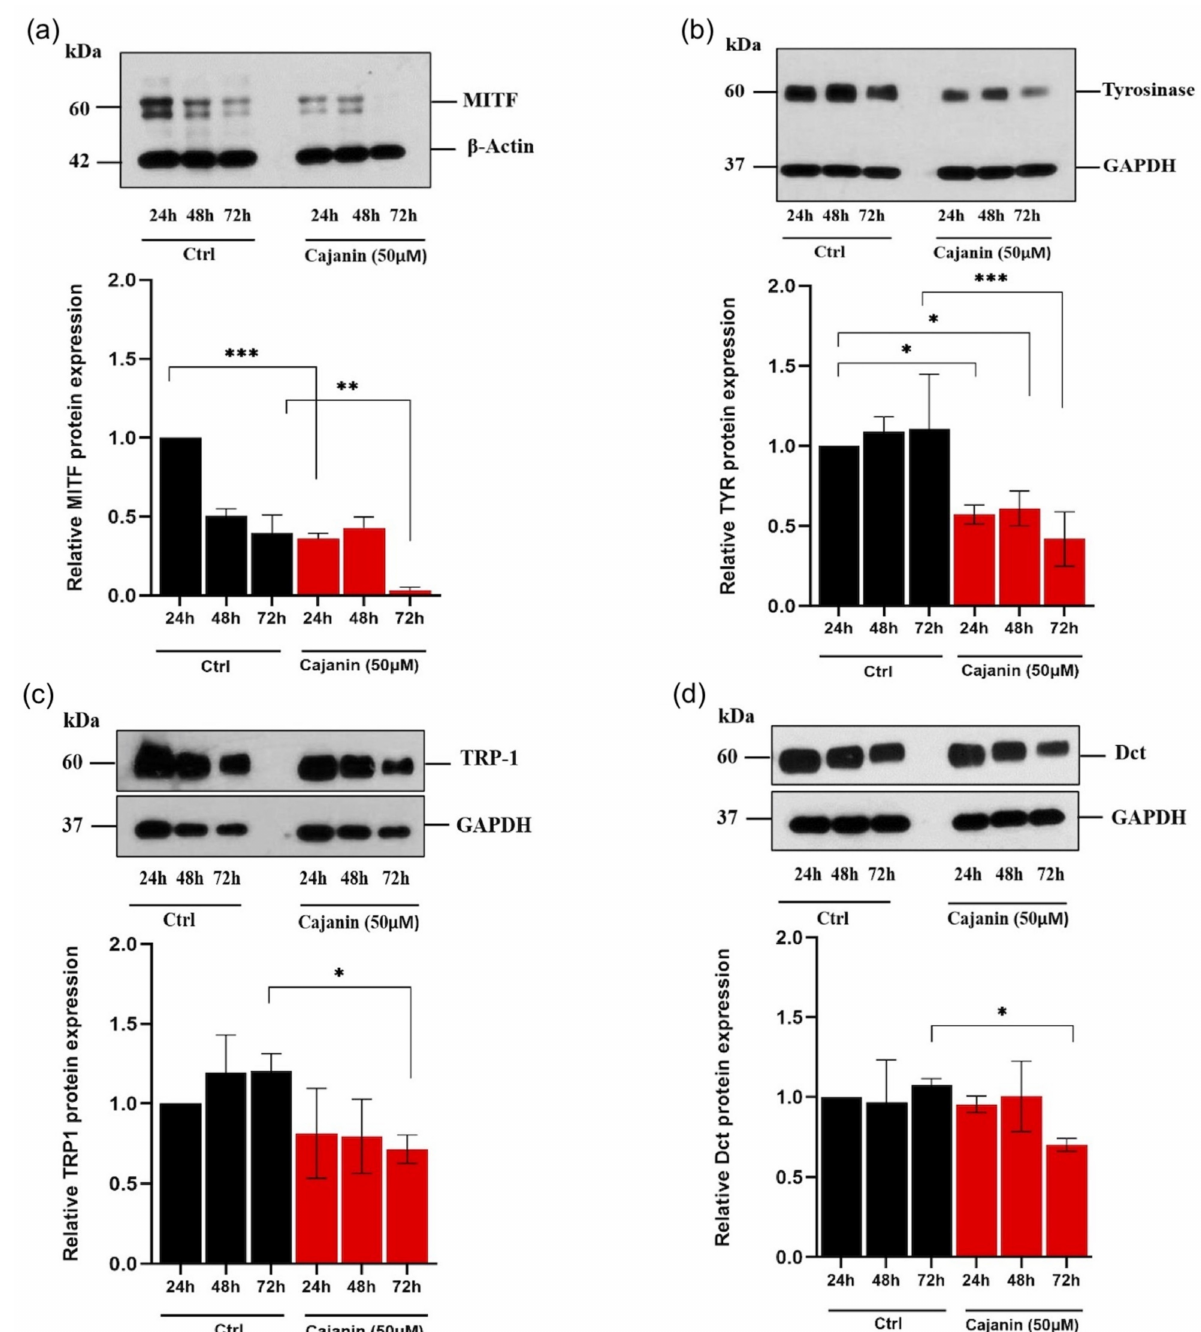
Figure 6. Cajanin attenuates expression levels of melanogenesis-related proteins in human MNT1 cells. After treatment with 50 µ M of cajanin, western blot analysis depicts the reduction of ( a ) MITF and ( b ) tyrosinase (TYR) protein levels early at 24 h of the incubation time. Meanwhile, the protein expression levels of ( c ) TRP-1 and ( d ) Dct were significantly diminished in MNT1 cells treated with cajanin (50 µ M) for 72 h compared with the control cells. All experiments were performed in triplicate and data are expressed as the mean ± SEM. * p < 0.05, ** p < 0.01, *** p < 0.005 versus non-treated cells